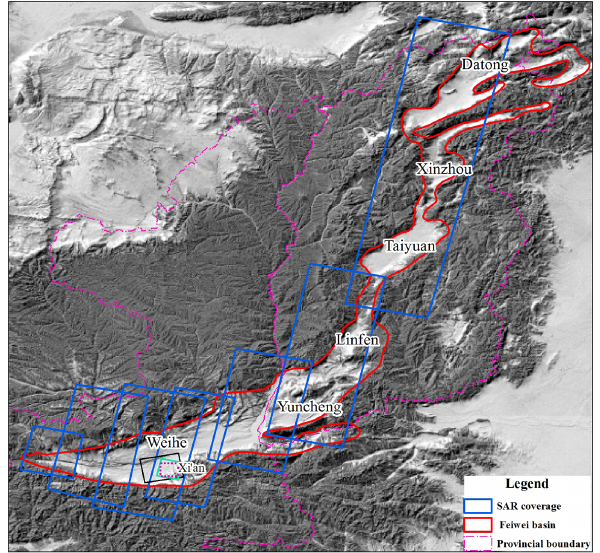
Figure 1. SAR coverage sketch map of Fenwei basin.